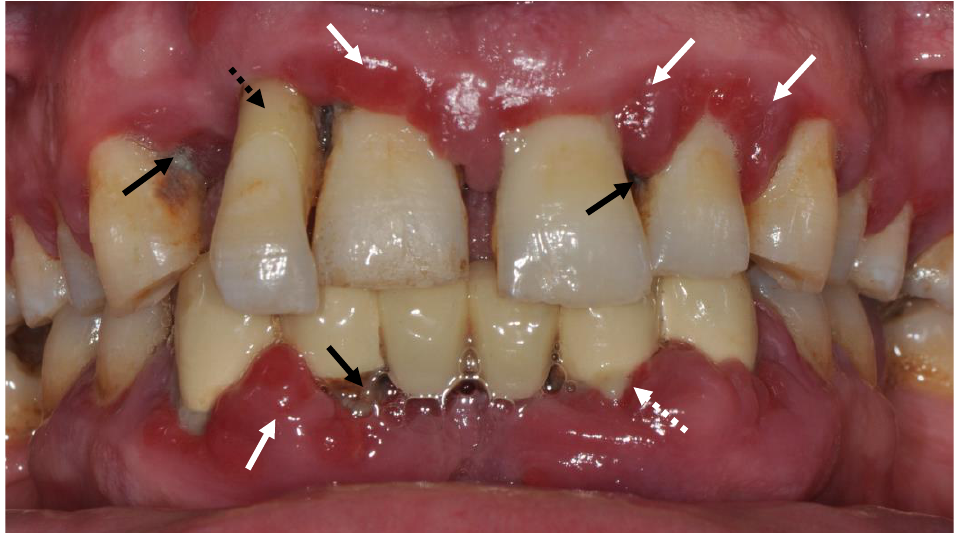
Figure 1. Clinical signs of severe periodontitis. White arrows: Signs of gingival inflammation (erythema, swelling and texture change). White dashed arrow: Suppuration. Black arrows: Dental deposits. Dashed black arrow: Signs of Gingival recession and pathologic tooth migration.